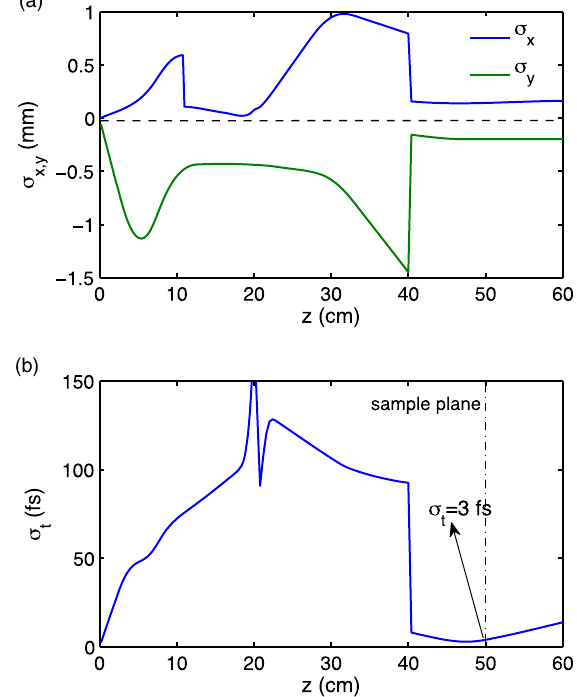
FIG. 6. Results of GPT simulations with the model distribution (see Table I). (a) rms transverse beam sizes of the beam envelope through the beam line: σ x (blue line) and σ y (green line). (b) rms bunch duration σ t through the beam line. The discontinuity at z ¼ 20 cm is an artifact of the rms calculation due to a change of reference frame during propagation in the bend